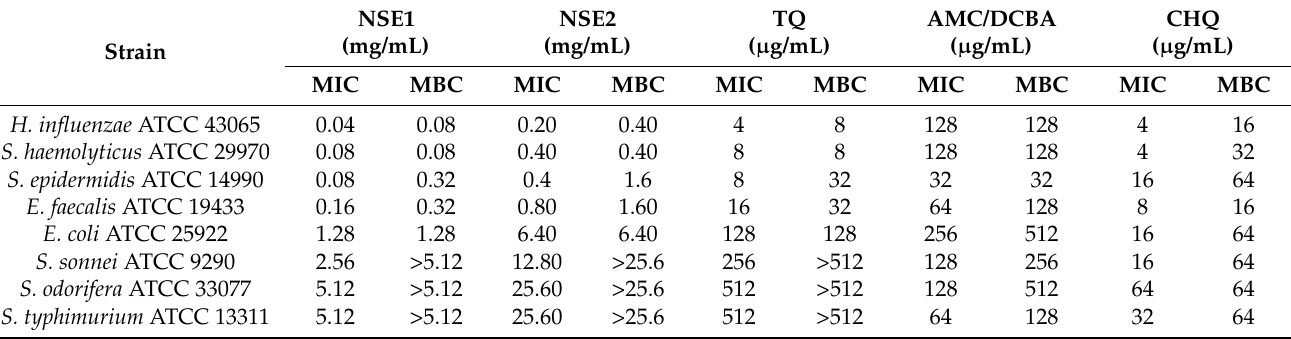
Table 5. Minimal inhibitory concentrations (MIC) or minimal bactericidal concentrations (MBC) of thymoquinone (TQ), thymol (THY), p -cymene (CY), Nigella sativa seed extracts obtained by supercritical CO 2 , extraction (NSE1 and NSE2), chlorquinaldol (CHQ) and a combination of amylmetacresol and 2,4-dichlorobenzyl alcohol (AMC/DCBA) in a 1:2 molar ratio against chosen pathogenic bacteria. For AMC/DCBA combination the concentration of amylmetacresol was presented.